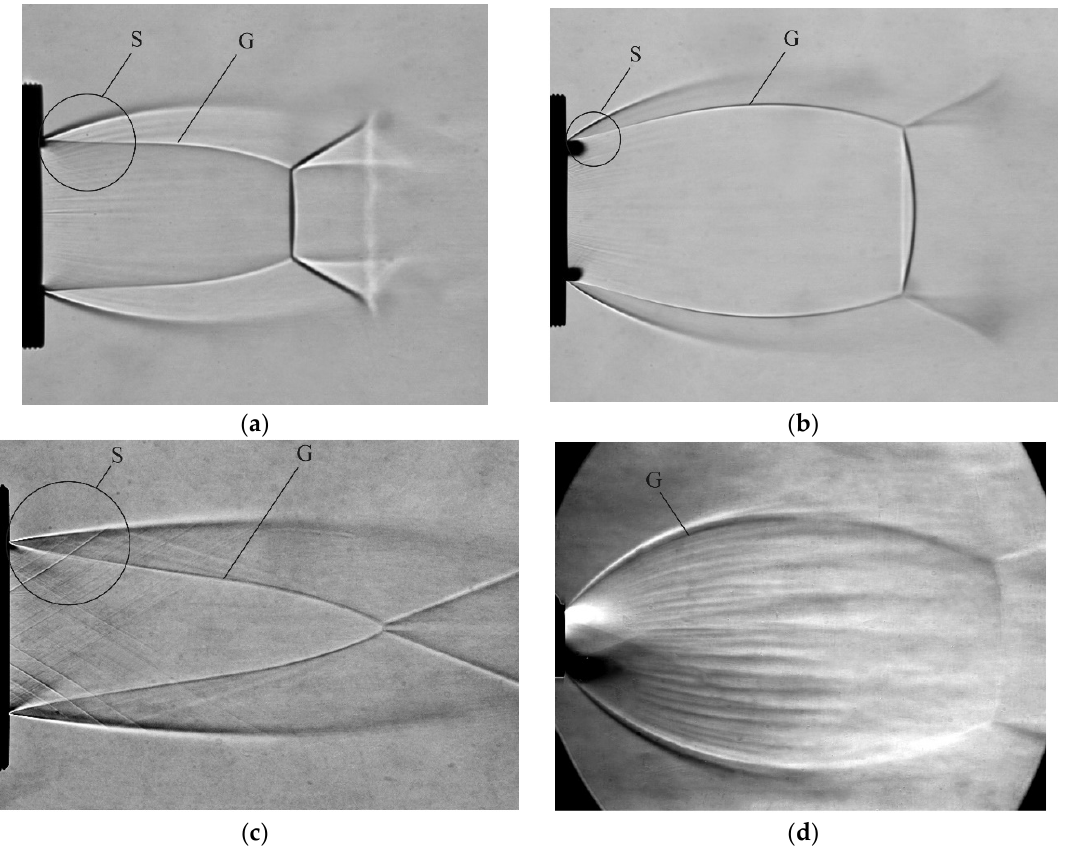
Figure 2. Visualization of the flow in an underexpanded jet ejected out of a sonic convergent nozzle with M a = 1.0 at flow regimes with n = 3.8 ( a ) and n = 8.2 ( b ); and out of a supersonic nozzle with M a = 2.0 at flow regimes with n = 2 ( c ) and n = 160 ( d ). Here G is the gradient flow feature, S is the region of its S-bending shape.